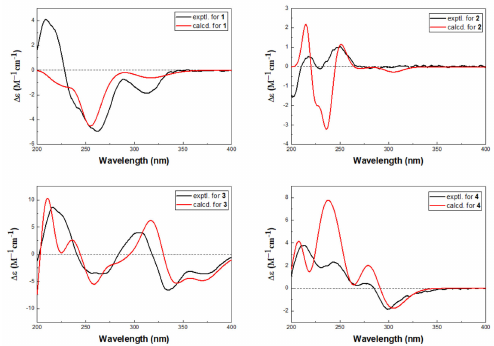
Figure 4. Experimental and calculated ECD spectra of compounds 1 − 4